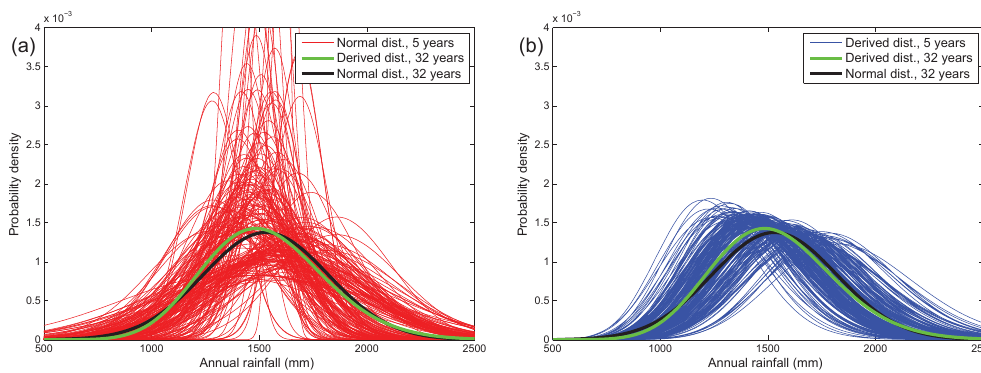
Figure 8. Estimated pdfs for 5-year subsamples using normal distributions (red, a ) and derived distributions (blue, b ) in Lugano.